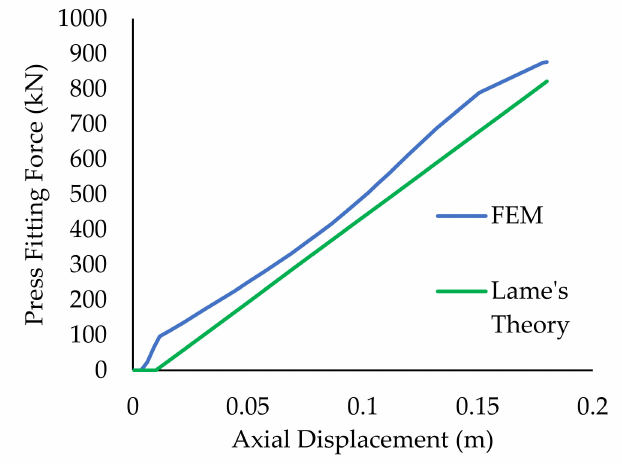
Figure 9. Press-fitting curves obtained from the finite element model (FEM) and Lame’s theory (straight green line).